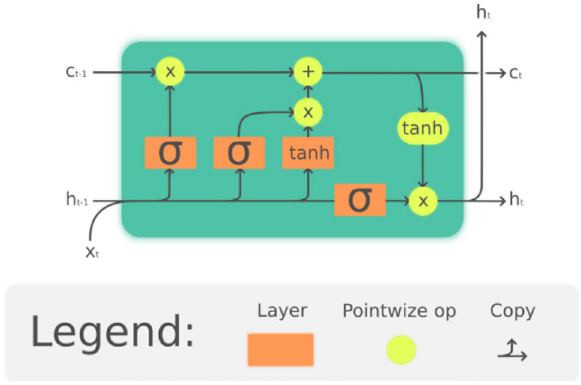
Figure 4. LSTM cell 54